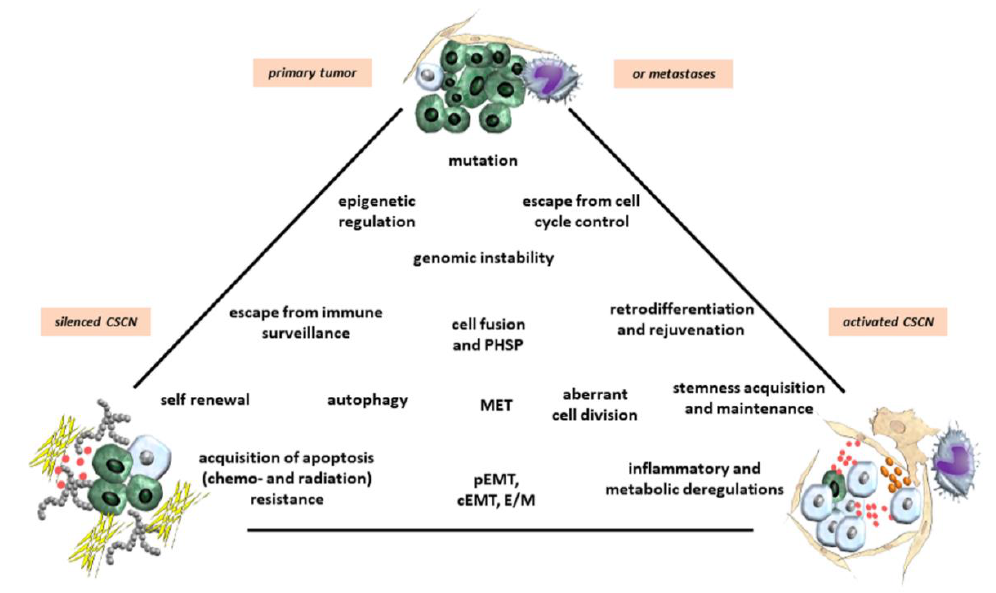
Figure 2. Various pathways and mechanisms can contribute to cancer cell plasticity during shuttling between (I) an activated cancer stem cell niche (CSCN) with cancer cell progenitor and CSC expansion, (II) a silenced CSCN displaying cancer cell dormancy, and (III) the dynamic alterations in the primary tumor tissue and metastases. Symbols are described in Figure